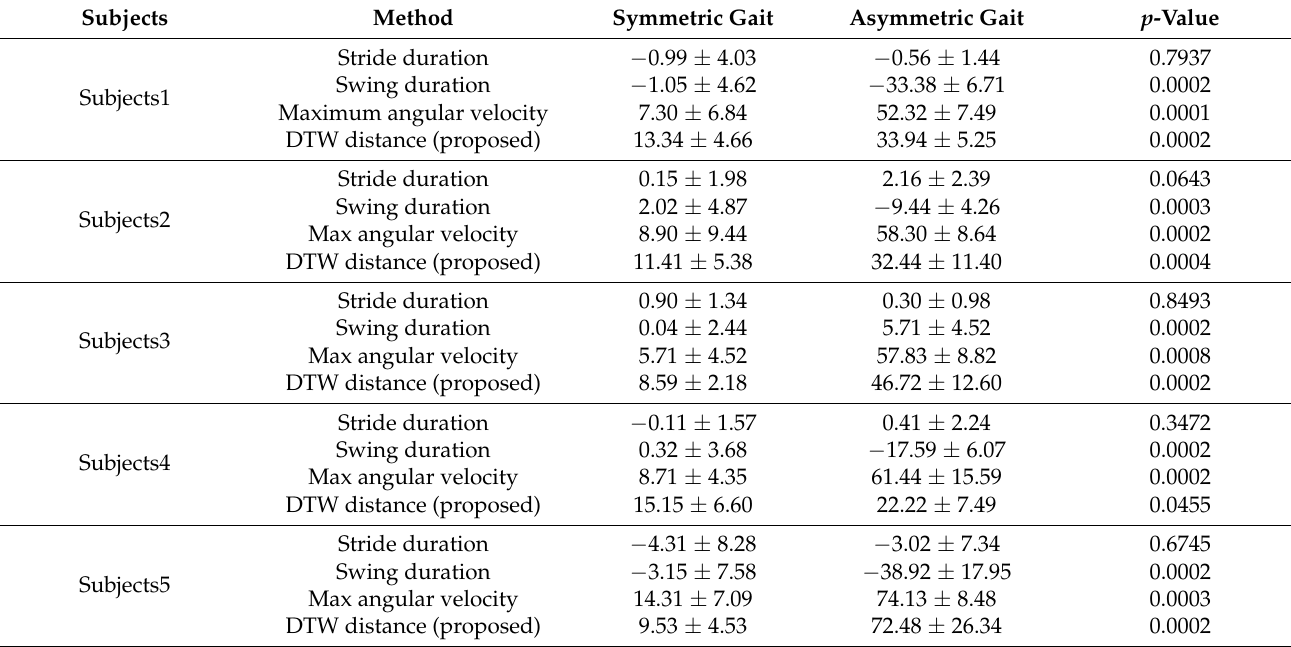
Table 1. Mean, standard deviation, and p -value for the analysis